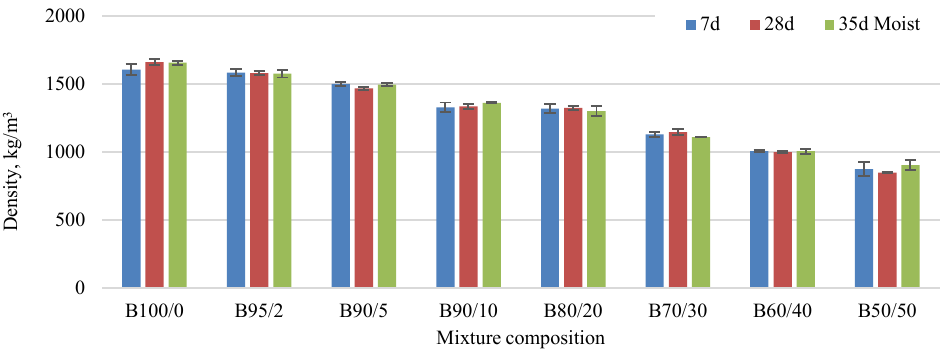
Fig. 8. Density of AAM with red brick and silica gel